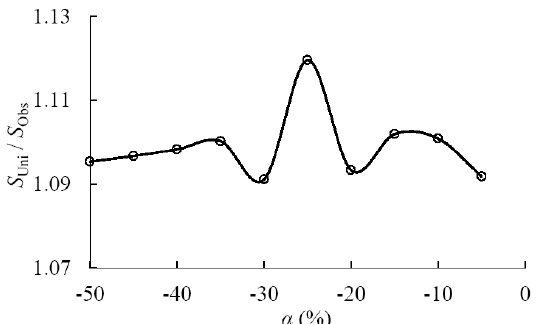
Figure 8. Introduced relative error( S Uni / S Obs ), for two scenarios, a uniform 2.0 km planetary boundary layer (PBL) ( S Uni ) relative to the observed profile ( S Obs ) shown in Figure 3. Both scenarios have the same XCH 4 .